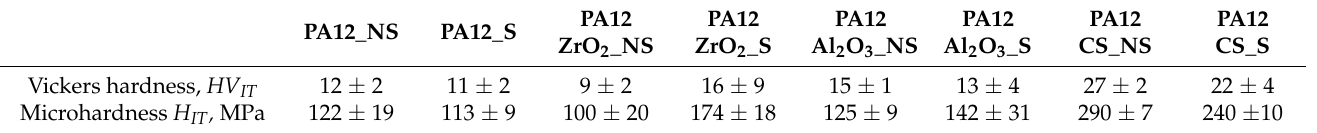
Table 6. Microhardness results of tested